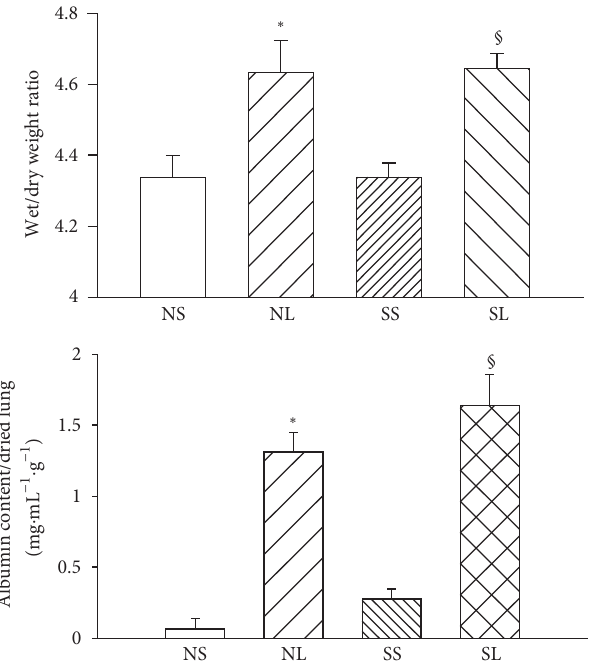
F 4: e albumin content in lung and lung wet/dry weight ratios in different groups aer LPS administration. Albumin content in the bronchoalveolar lavage �uid was calculated as �(mg of albumin)/(mL of lavage �uid)�/(g of dried lung weight) aer LPS administration (15mg/kg, i.v.) in different groups. NS: normal rats injected with saline; NL: normal rats injected with LPS; SS: STZ- treated rats injected with saline; SL: STZ-treated rats injected with LPS. Data are expressed as